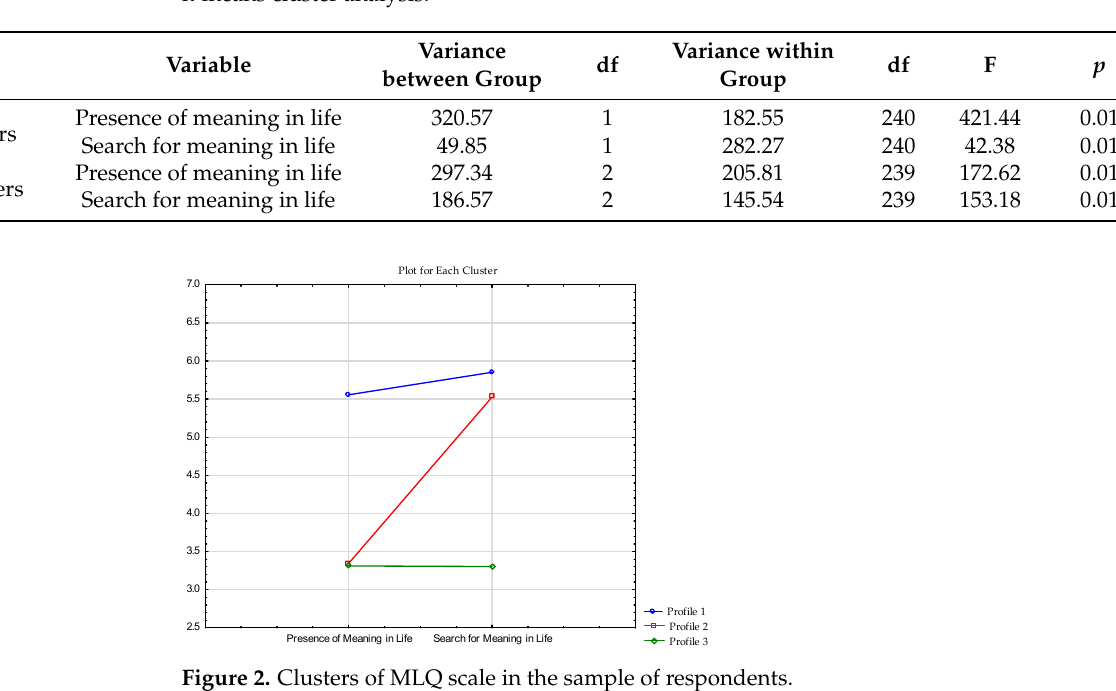
Table 2. Variance within and between groups for the Meaning of Life Questionnaire (MLQ) : results of k-means cluster analysis.